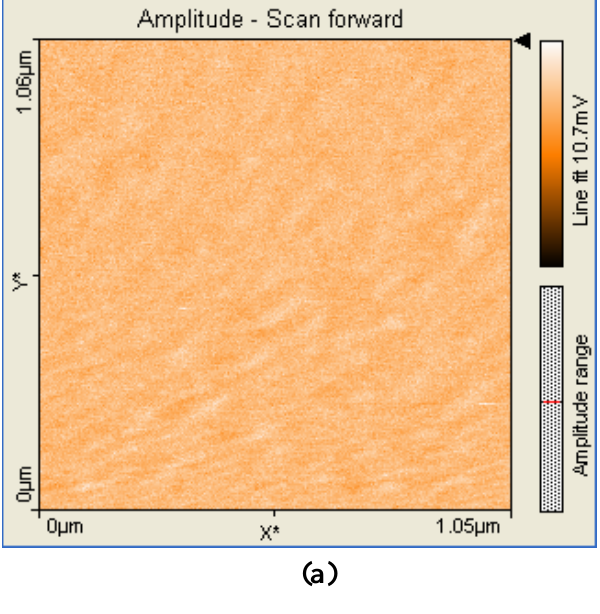
Figure 14. 2D (a) and 3D (b) AFM images (1.05×1.06µm) and particle analysis of the hybrid material 1a-AB